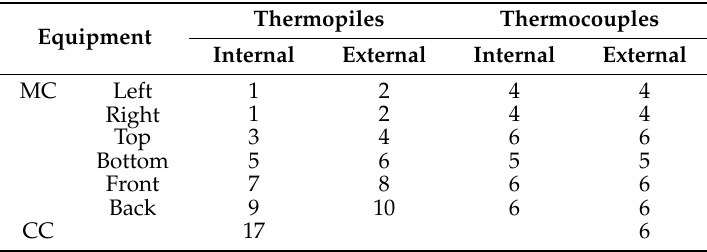
Table 2. Thermopiles and thermocouples arrangement.